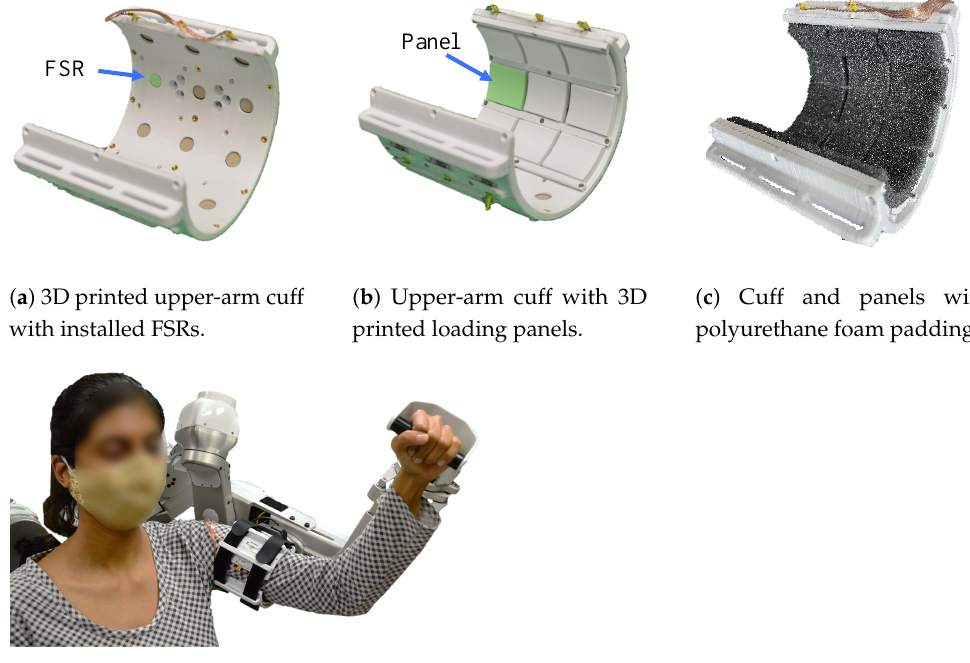
Figure 1. The design introduced in this work is implemented for an upper-arm exoskeleton interface. The upper-arm cuff uses 24 panels, each covered with foam padding, to allow for comfortable interaction between the wearer and the